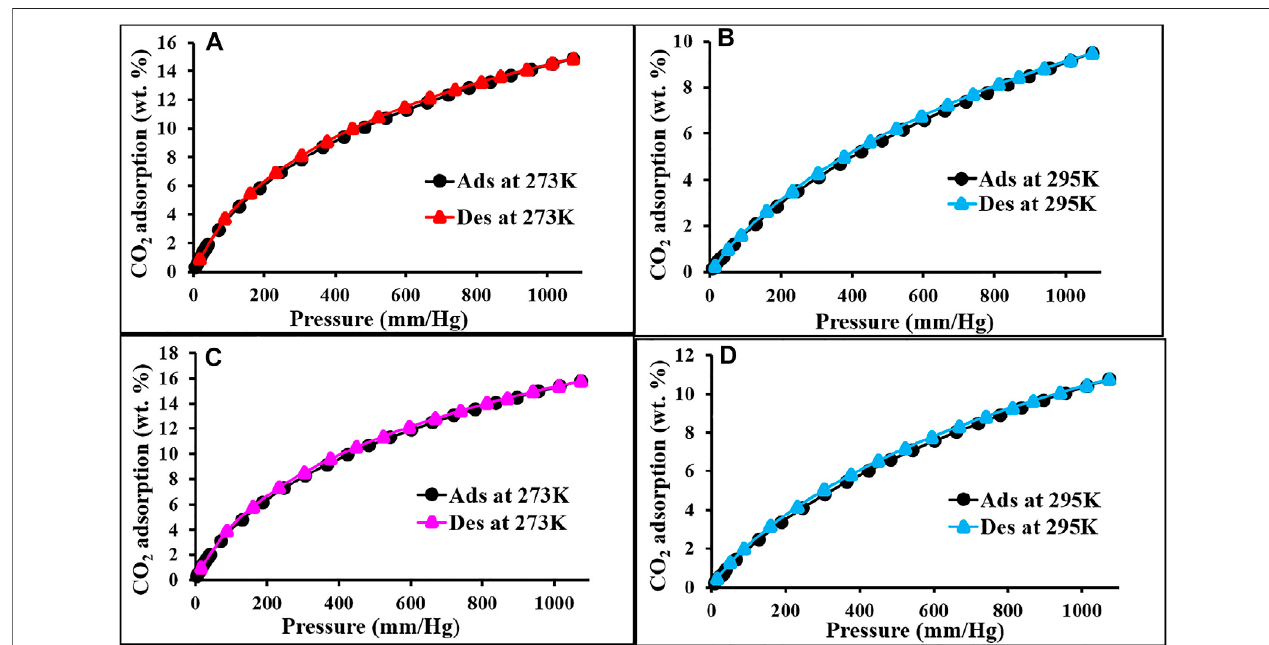
FIGURE 4 | CO 2 adsorption and desorption isotherm of p-2CzPN (A,B) and p-4CzPN (C,D) at 273 and 295 K, respectively.